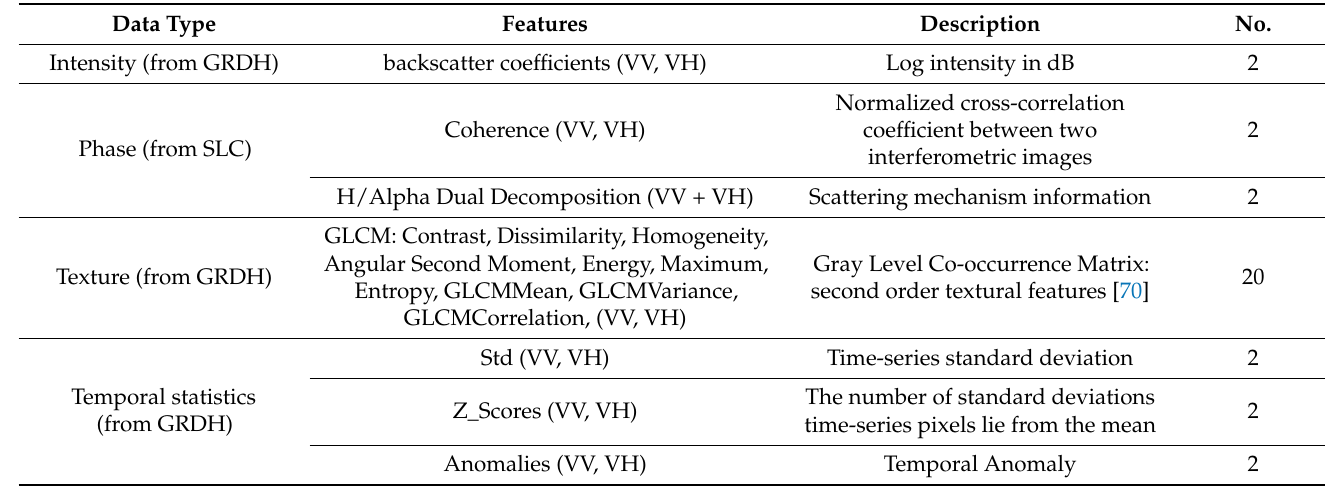
Table 2. Random forest SAR-derived